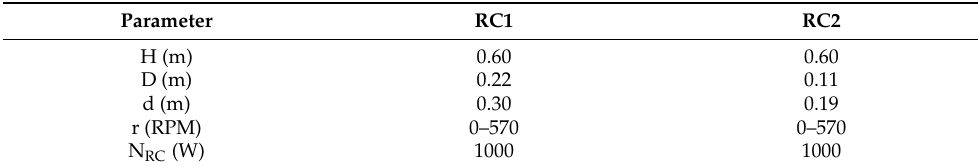
Table 4. Parameters of the tested rotors.